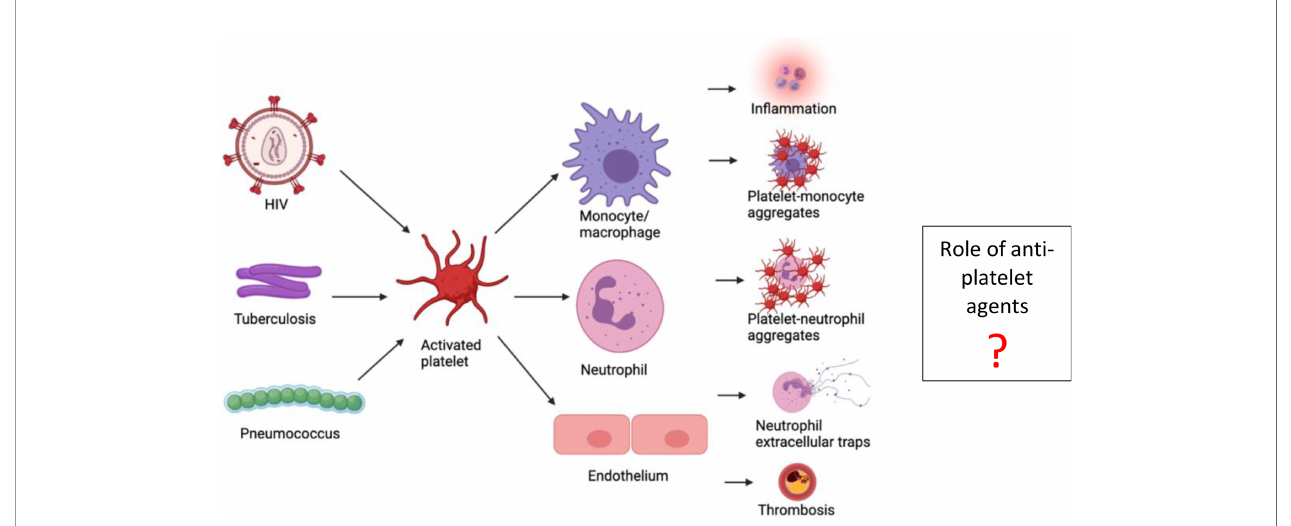
FIGURE 1 | Summary of the role of platelet activation in the pathophysiology of HIV, tuberculosis and pneumococcal